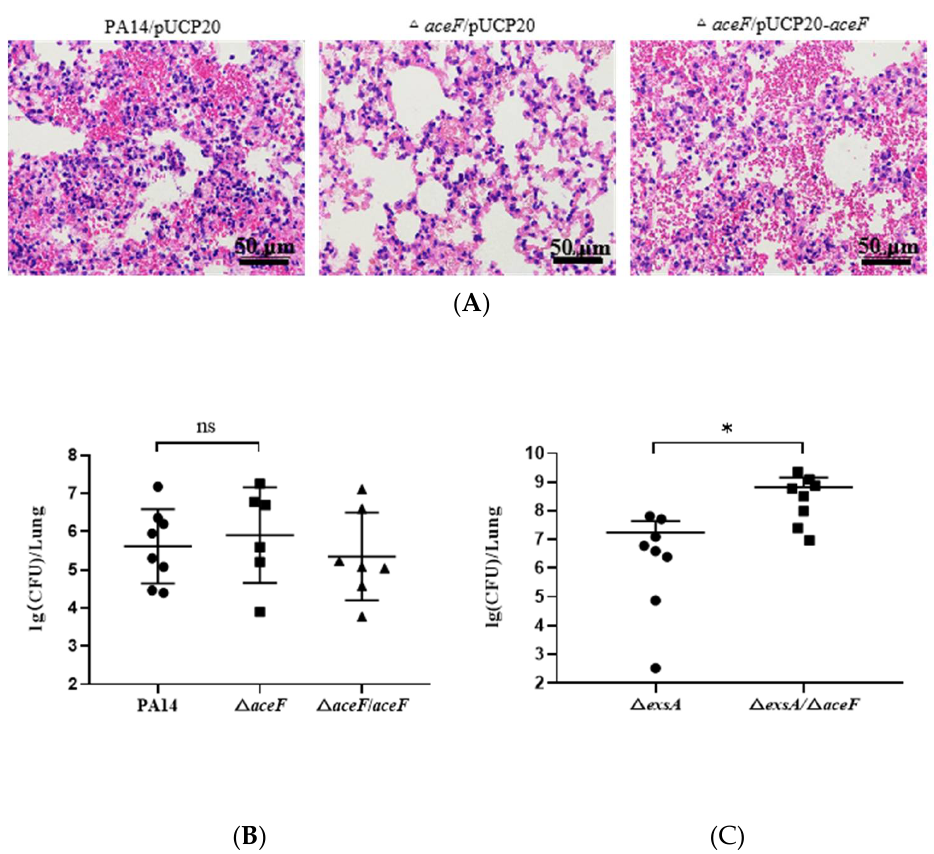
Figure 5. Mutation of the aceF gene affects bacterial pathogenesis in a murine acute pneumoniae model. ( A , B ) Each mouse was intranasally inoculated with 4 × 10 6 CFU of bacteria. ( A ) At 12 hpi, the lung sections were observed with a 20× objective lens following hematoxylin and eosin staining. ( B ) Bacterial numbers in the lungs from the infected mice at 12 hpi. ( C ) Each mouse was infected with 4 × 10 8 CFU of Δ exsA or Δ exsA Δ aceF. At 12 hpi, the bacterial numbers in the lungs were determined. ns, not significant; * p < 0.05 by ANOVA.